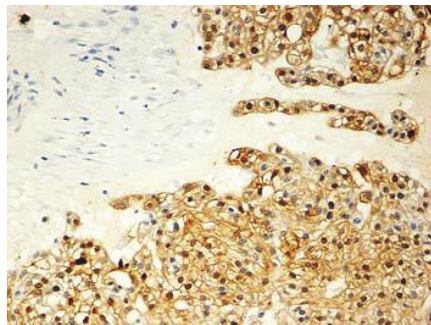
Figure 5: Positivity of the tumor cells for S100